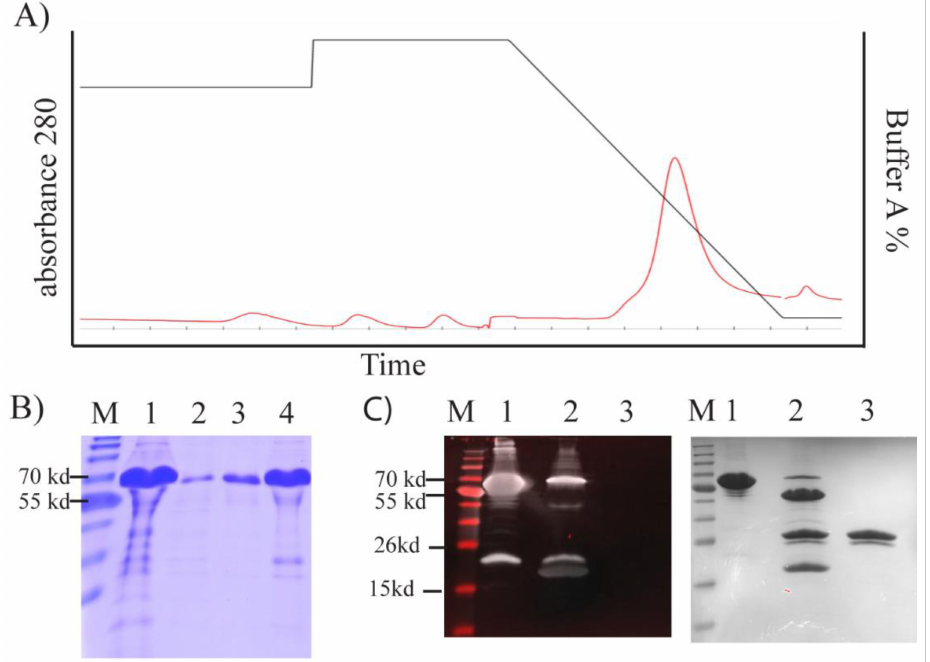
Figure 5. Bacterially expressed TP–Trx or TP purification and characterisation. ( A ) FPLC diagram of TP–Trx elution from Histrap column with decreasing buffer A (i.e., increasing elution buffer B) shown in black and the relative absorbance at λ 280 is shown in red. ( B ) SDS–page and Coomassie Blue staining of samples taken before and during TP purification. 1: TP in inclusion bodies; 2: flow-through; 3: wash; 4: elution (pooled). ( C ) Analysis of TP Western blotting. M: NIR ladder; 1: TP–Trx; 2: TPTrx after TEV enzyme cleavage; 3: TEV enzyme only. All wells were run in parallel using the same gel. The gel was cut in half. The first half was stained with Coomassie Blue (right image), and the other half was transferred into a PVDF membrane and stained with the antibody (left image) as described in the Methods section. Antibody staining of the membrane was performed using the Odyssey imaging system and Coomassie staining using Biorad Chemidoc